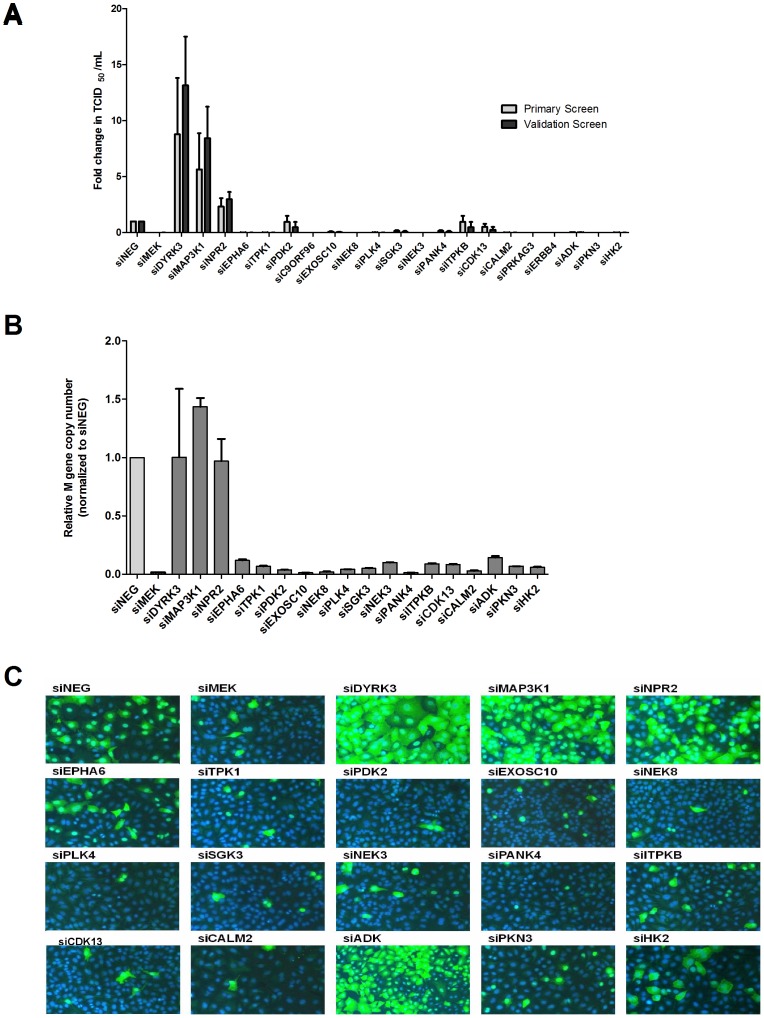
Validation of human protein kinase genes affecting influenza virus replication.A549 cells were reverse transfected with 50 nM of a non-target negative control siRNA (siNEG) or with siHPK and infected at a MOI = 0.01 with A/WSN/33. (A) 72 hours after infection, supernatants were harvested and the viral titers were determined by TCID50 assay on MDCK cells (B) After a 48 hour infection, the effect of siRNA silencing on influenza virus replication was measured by quantifying the levels of influenza M gene expression. The RNA from siRNA-transfected and WSN-infected A549s was isolated and used for quantification with an influenza M-specific primer/probe set. Light gray bars indicate controls. Data show mean±SEM from 3 independent experiments. (C) After a 48 hour infection, cells were fixed, permeabilized and incubated with an anti-influenza virus NP monoclonal antibody and subsequently with an Alexa-488 goat anti-mouse secondary antibody and DAPI. The intracellular distribution of the viral RNPs (NP, green) and cellular nuclei (DAPI, blue) are shown.